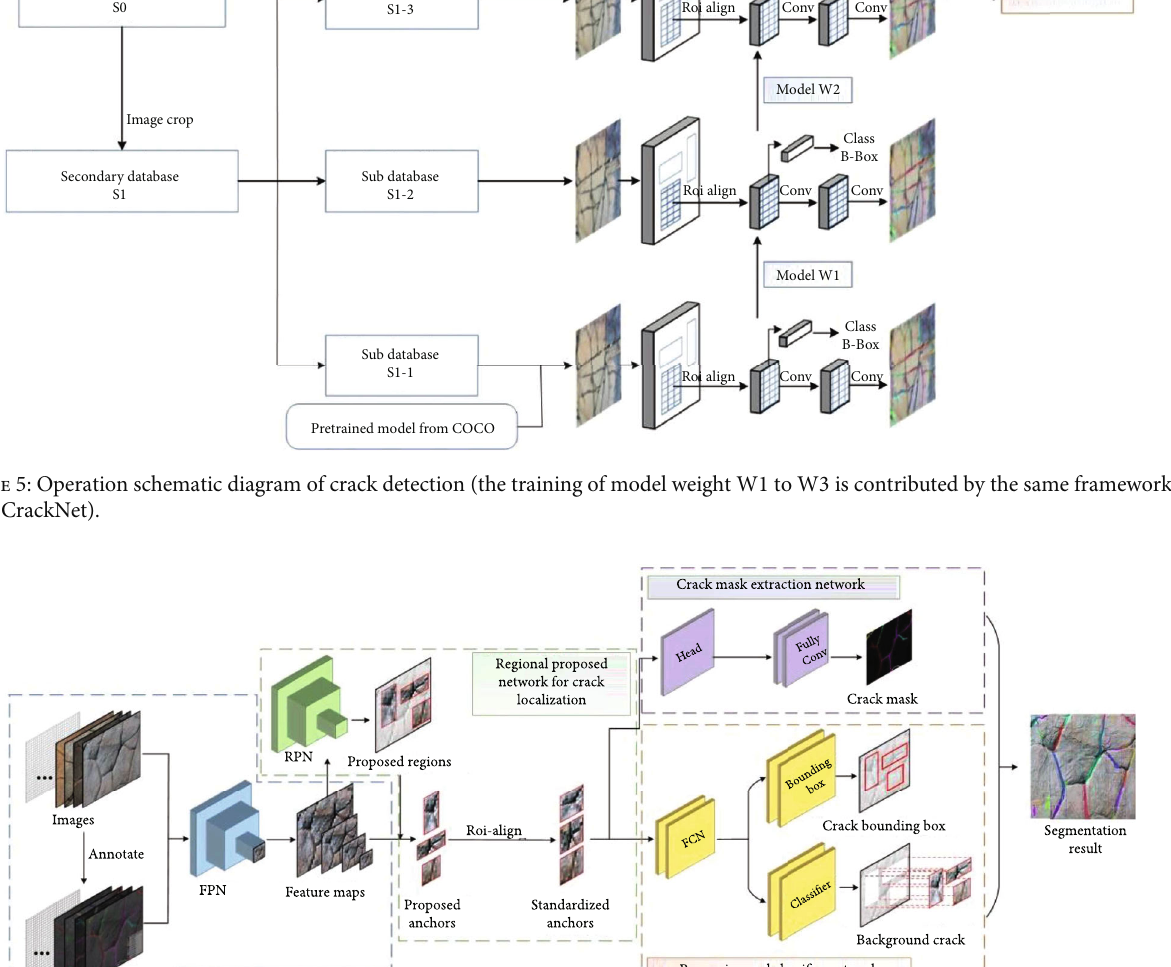
Figure 7. Convolutional neural network (CNN) can extract